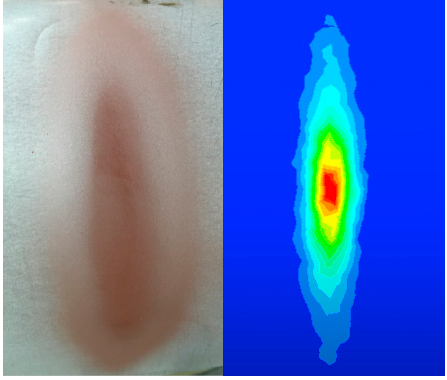
Figure 20. Cylindrical spraying: comparison of experimental and simulated coating film.